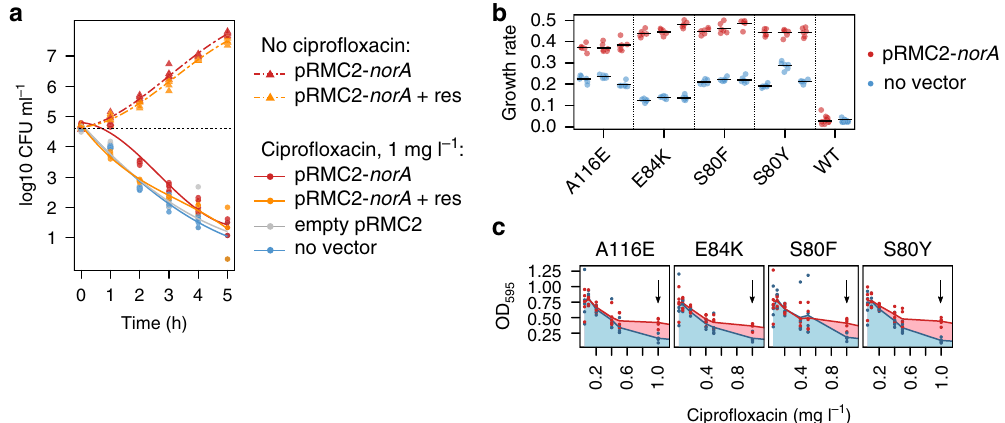
Fig. 5 The mechanism of norA potentiation. a Exponentially growing cells were exposed to 1mg l − 1 of cipro fl oxacin and viable cells counts were estimated by plating on TSB agar. Four treatments were compared: (i) norA overexpression = red solid line, (ii) norA overexpression and reserpine (33 μ M) inhibition = orange solid line, (iii) empty vector control = grey line, and (iv) no vector control = blue line. In addition, cell density was measured in treatments (i) and (ii) without cipro fl oxacin (red dash-dotted line and orange dash-dotted line, correspondingly). For each time-point, six independent replicates per treatment were measured (with the exception of the pRCM- norA cells in cipro fl oxacin at 0 h which had N = 5). The lines show model fi t for polynomial regression ( F 23, 191 = 622.6, p -value < 2.2e − 16). Post-hoc comparisons are shown in Supplementary Table 14. b Growth rate of grlA mutants with or without norA overexpression. We estimated the growth rate of the RN4220 wild type (WT) and three independently obtained mutants carrying each grlA substitution in the presence of 1 mg l − 1 of cipro fl oxacin. Growth rate in cells carrying pRMC2- norA (red) or cells without the vector (blue) was determined using growth curves shown in Supplementary Fig. 10b. Black horizontal lines show the mean growth rate of independent cultures ( N = 6 per mutant/ treatment combination for A116E, E84K, S80F and S80Y, N = 11 for WT pRMC2- norA and N = 12 for WT no vector). Paired two-sided t -test comparing the means in the mutants with and without pRMC2- norA : t = 11.958, d.f. = 11, p = 1.206e − 07. Two-sided t -test comparing pRMC2- norA and no vector control in WT: t = 0.96281, d.f. = 12.136, p = 0.3544. c Representative dose-response experiments for grlA mutants. Red lines show mean optical density with norA overexpression, and blue lines show mean density without overexpression. Black arrow shows the concentration used during experimental evolution. Five independent cultures were used per mutant/treatment/concentration. The results for all mutants are shown in Supplementary Fig. 10a. The difference of means between pRMC2- norA and no vector cells at 1 mg l − 1 for all mutants was tested using two-sided paired t - test: t = − 18.712, P = 1.09e − 09, d.f. =